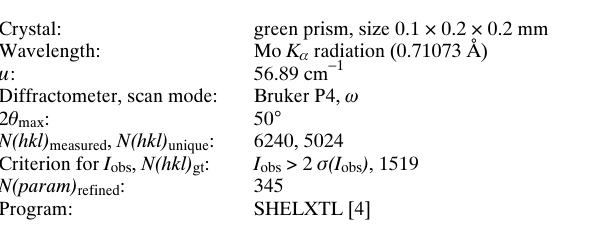
Table 1. Data collection and handling.